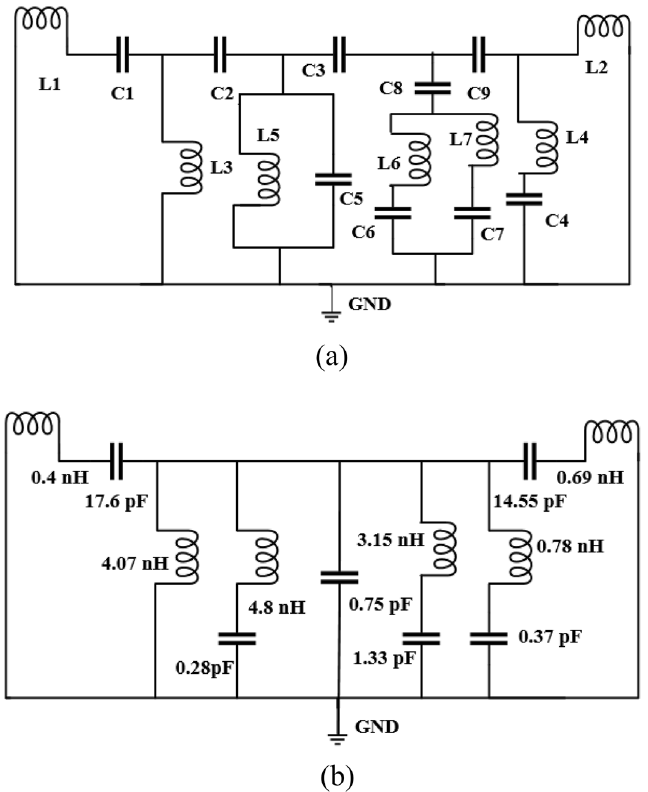
Figure 14. ( a ) Primary equivalent circuit of the proposed unit cell. ( b ) Modified equivalent circuit of the proposed unit cell.